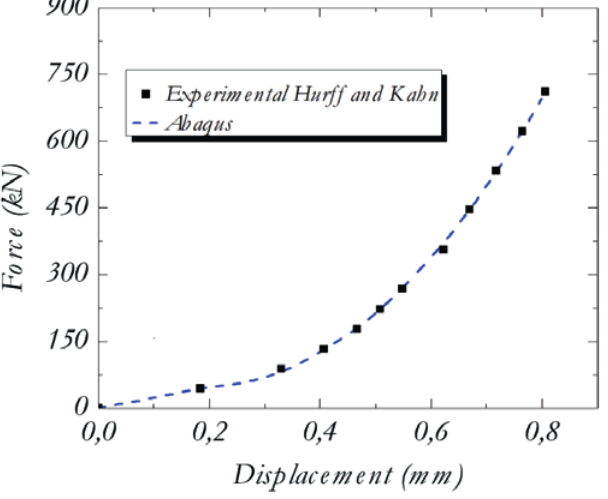
Numerical and experimental axial response of elastomeric bearing